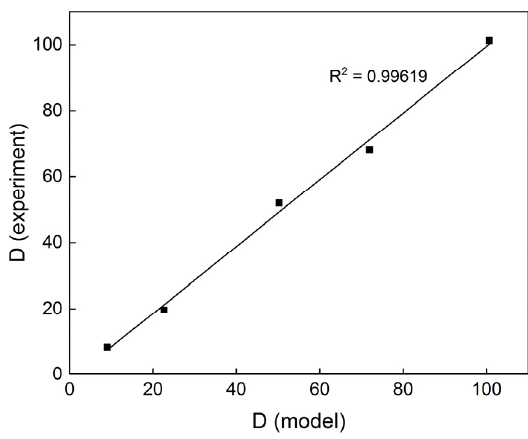
Figure 8. The correlation of grain size between calculated and experimental.